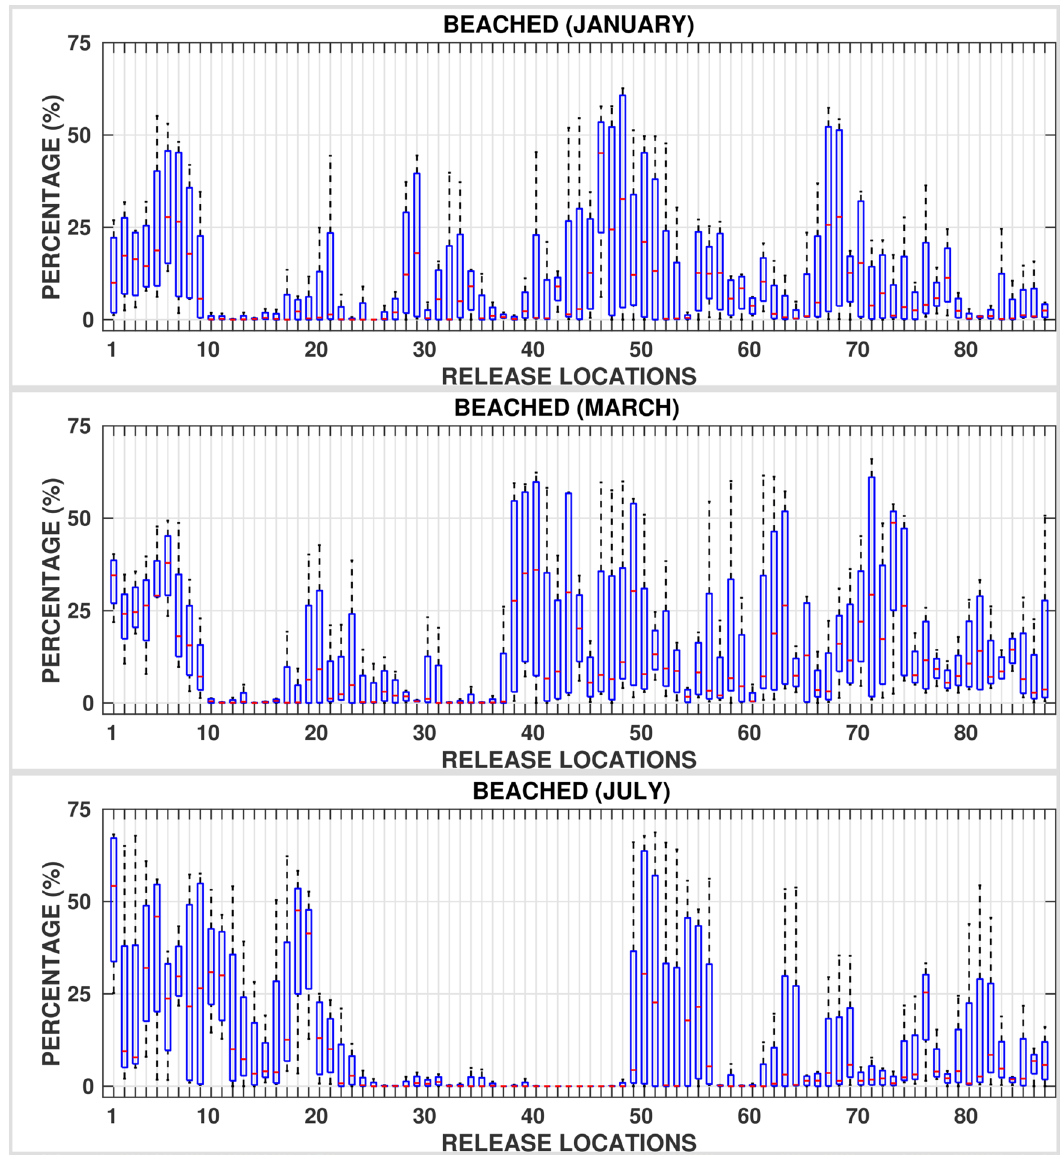
Figure 8. Percentages of oil beached, twenty (20) days after the commencement of the spill for each release location ( RL i : i = 1 : 87 ) for all the 4 years considered in